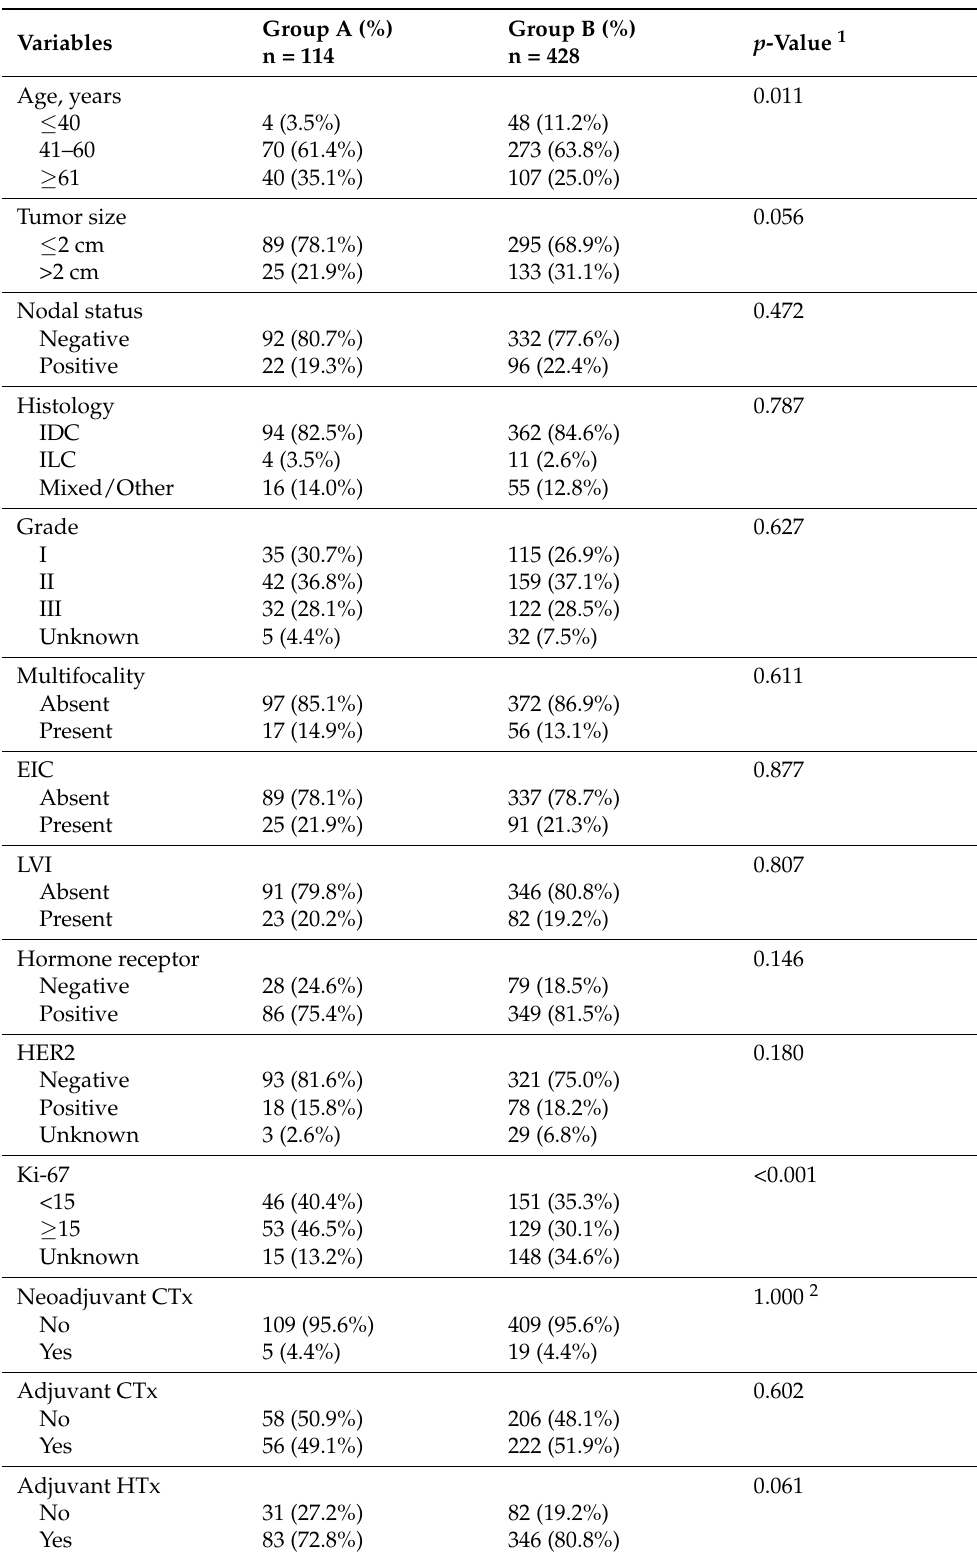
Table 2. Patients’ clinicopathological characteristics according to final margin status after defini- tive